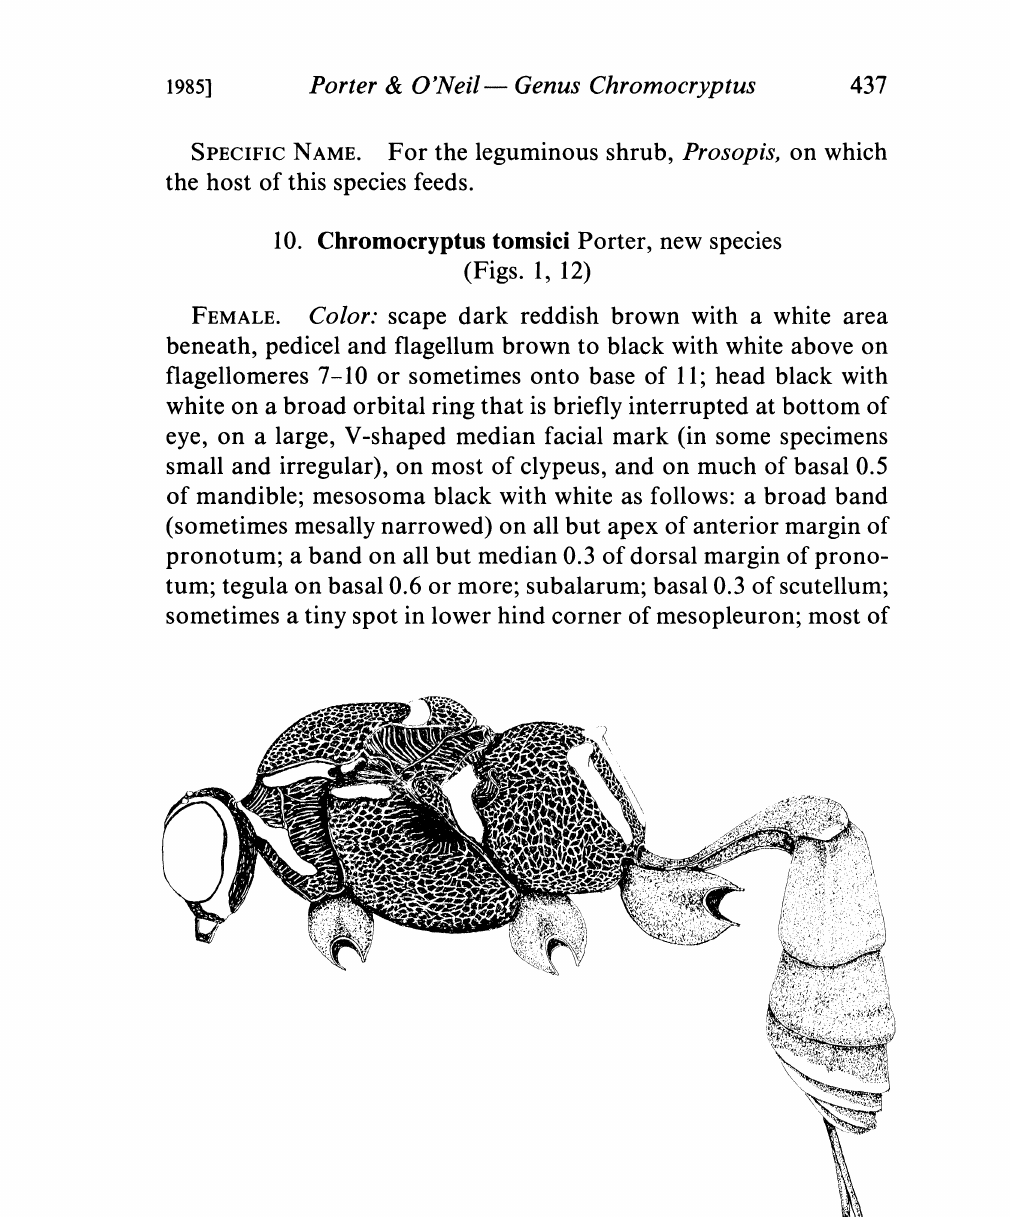
.. Holotype. Body in lateral view, showing